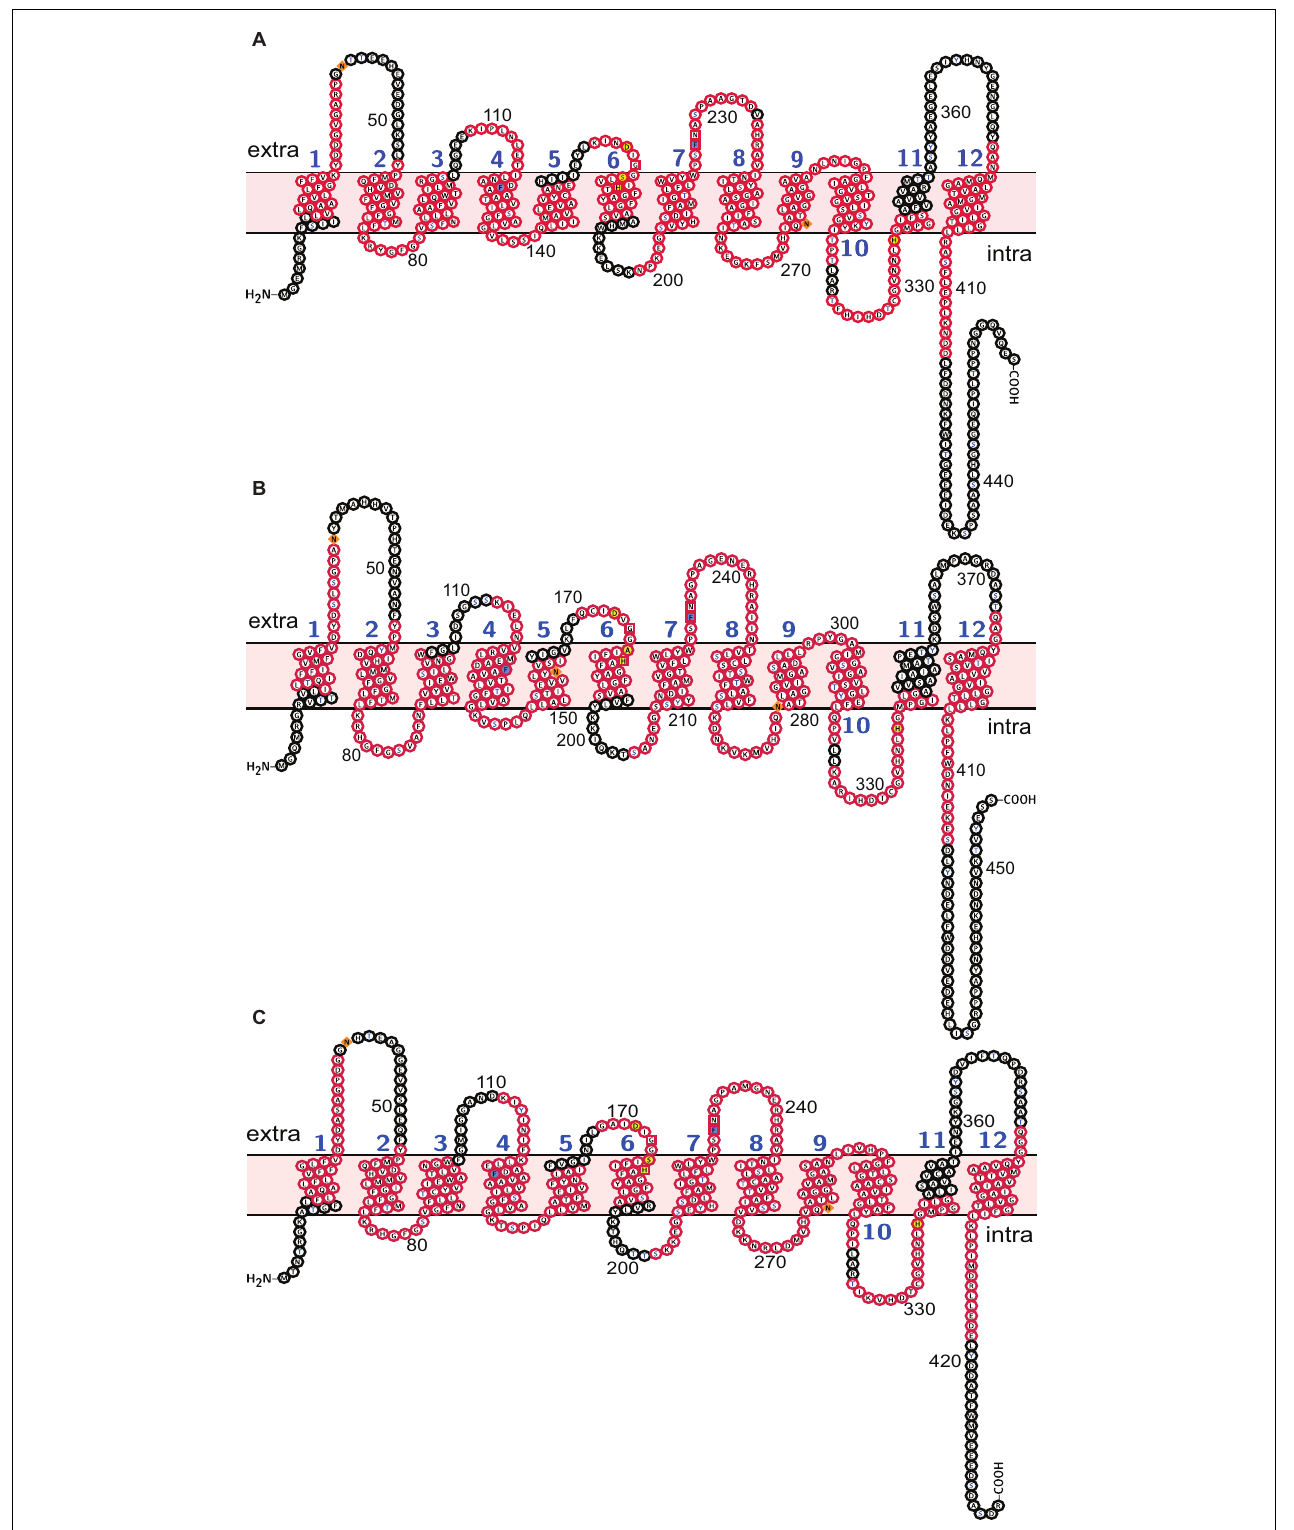
FIGURE 2 | Molecular characterization of (A) Rh type A; (B) Rh type B; (C) Rh type C of M. manhattensis . Transmembrane domains are labeled in blue numbers (1–12). Membrane topology is in light pink. Potential N-glycosylation sites are diamond-shaped and filled with orange. Potential phosphorylation sites are of blue characters. Phenylalanine gates of the ammonia channel are filled with light blue. Residues involved in NH 4 + recruitment are box-shaped. Residues involved in deprotonation are filled with yellow. Conserved motifs predicted by MEME are in red frames.